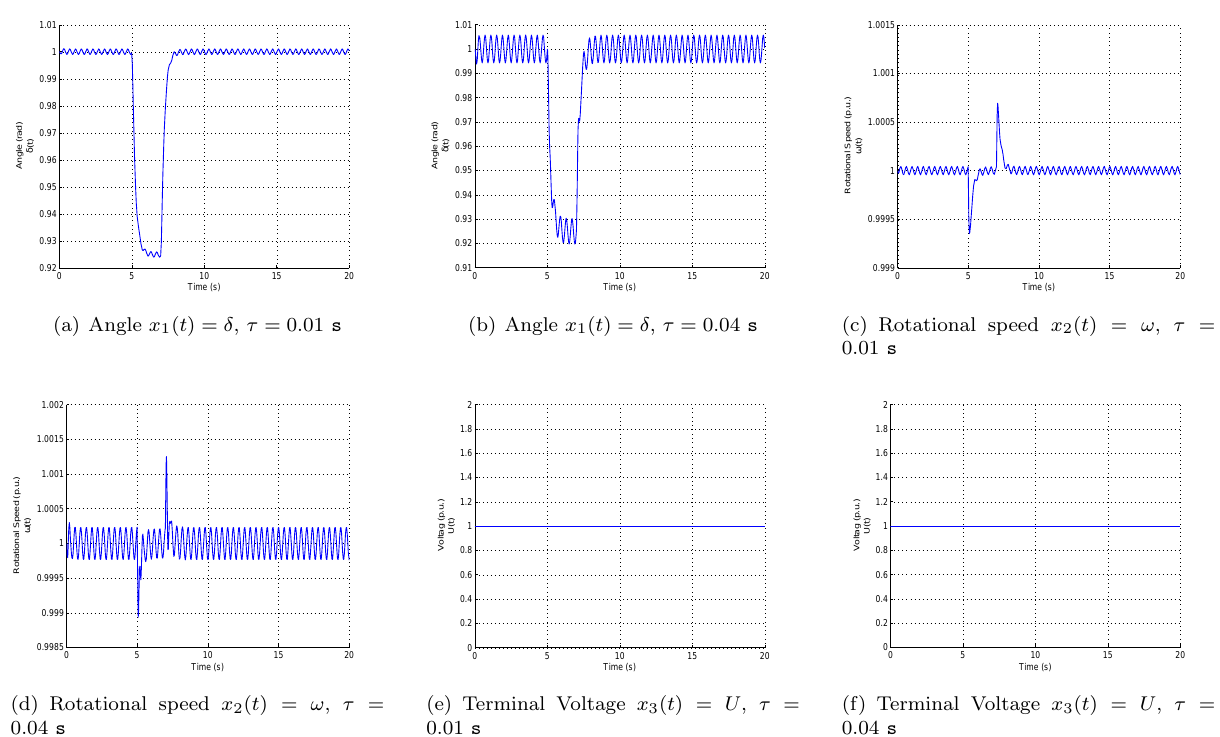
Figure 4: Results of the simulation of the model in eq.(40) with a sudden step in the load torque for time delay of 0.01 s and 0.04